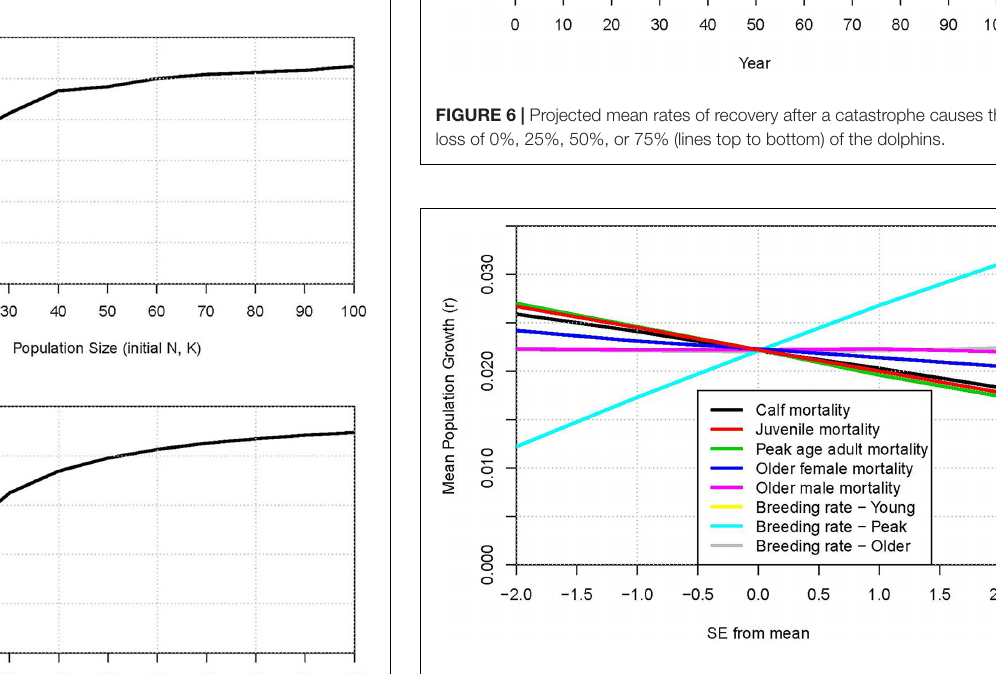
FIGURE 7 | Relative impacts of uncertainty in parameter estimates: Population growth rate ( r ) when demographic rates are varied from − 2 SE to +2 SE around the mean estimated values. Lines from top to bottom on right hand ends: Breeding rate – Peak (positive slope); three superimposed lines with slope ≈ 0: Older male mortality, Breeding rate – Young, Breeding rate – Older; lines with negative slopes: Older female mortality; Calf mortality; Juvenile mortality; Peak age adult